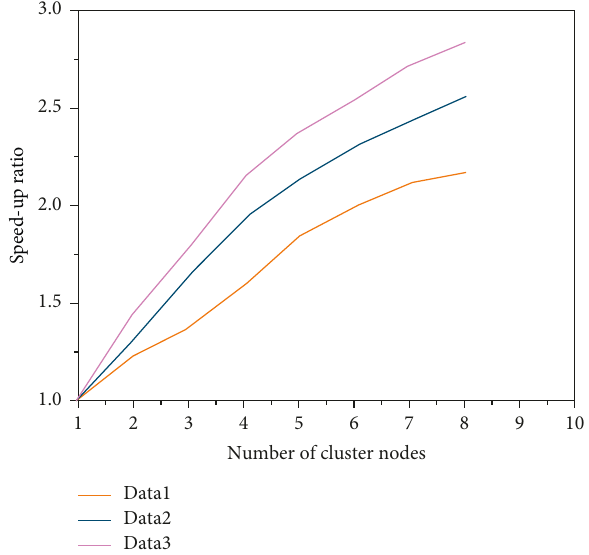
Figure 6: Acceleration ratio performance test